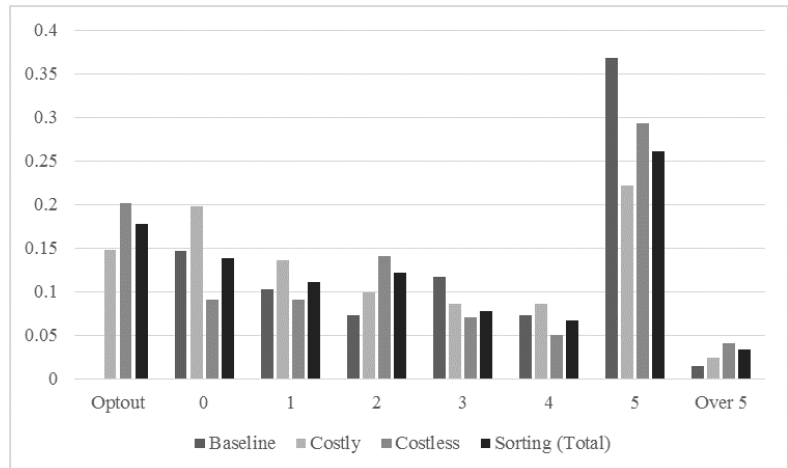
Figure 1. Distribution of amounts passed.